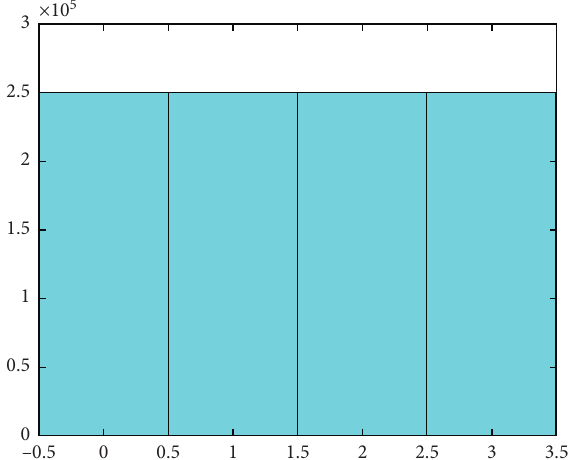
Figure 15: Histogram for 1,000,000 values of the modulo 4 tactics.